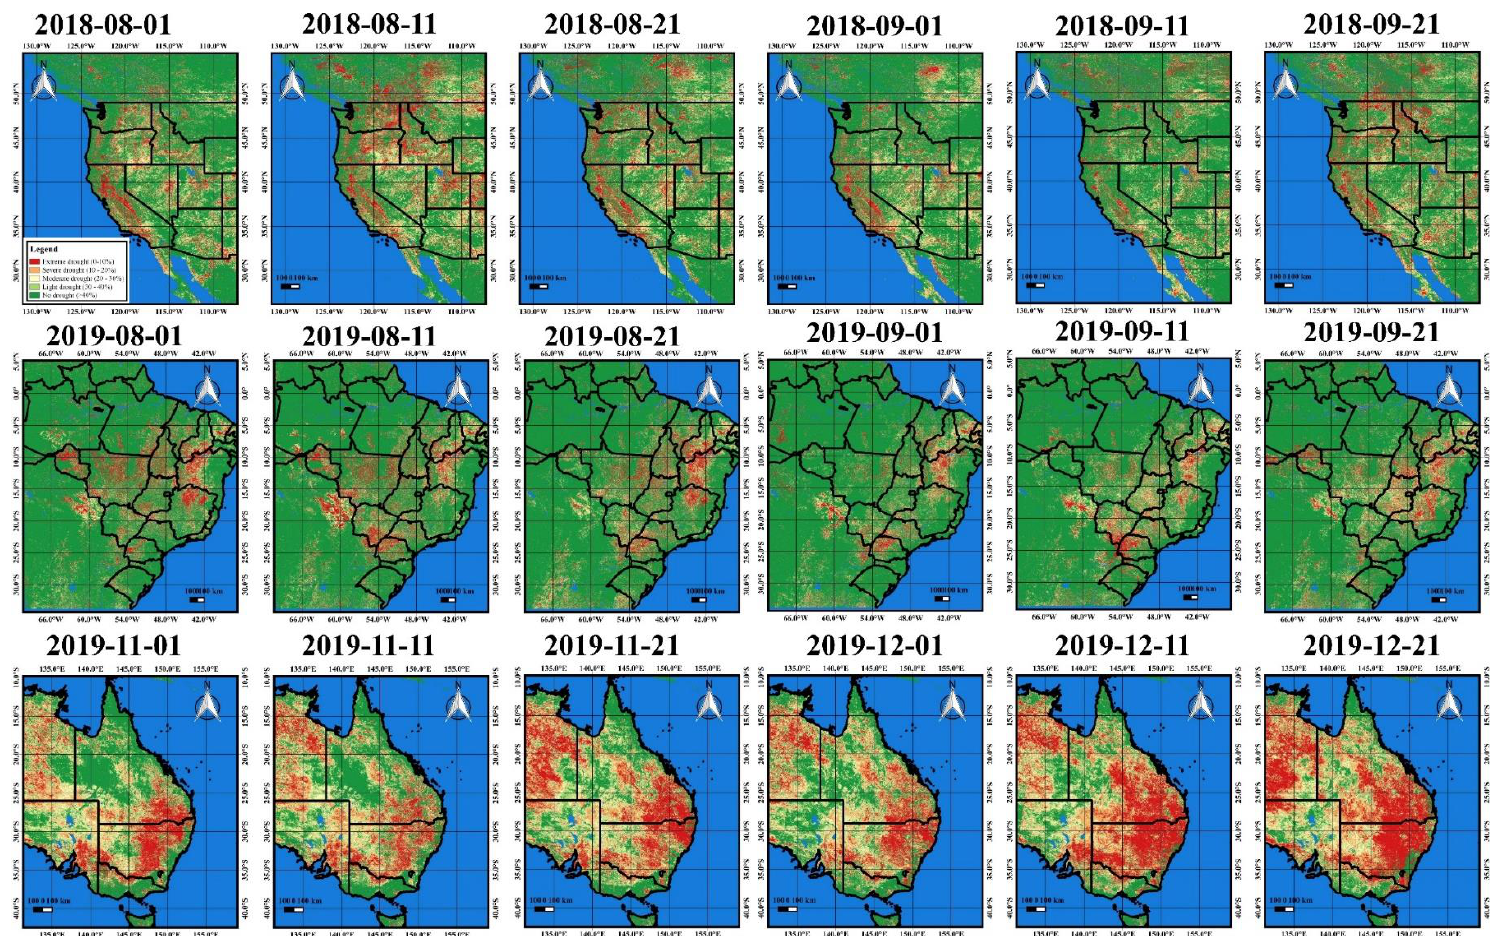
Figure A2. Vegetation conditions (represented by vegetation condition index, VCI) during the propagation of wildfires at the three study sites, i.e., USA (i.e.,